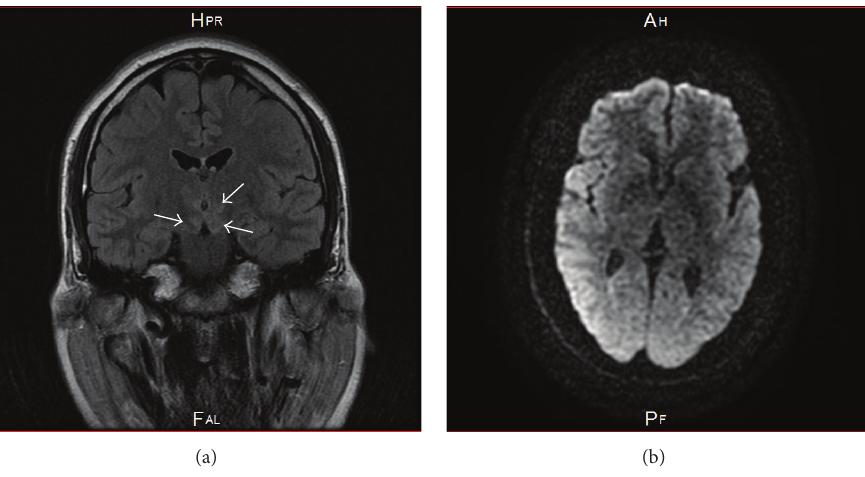
Figure 2: Brain MRI scans ten days after initiating the antibiotic therapy showing residual hyperintense signal alternations in the hypothalamus, in the left crura cerebri, and in the left thalamus (arrows) on the coronal FLAIR-T2 in (a) and complete regression of the signal abnormality on the axial diffusion weighted imaging DWI in